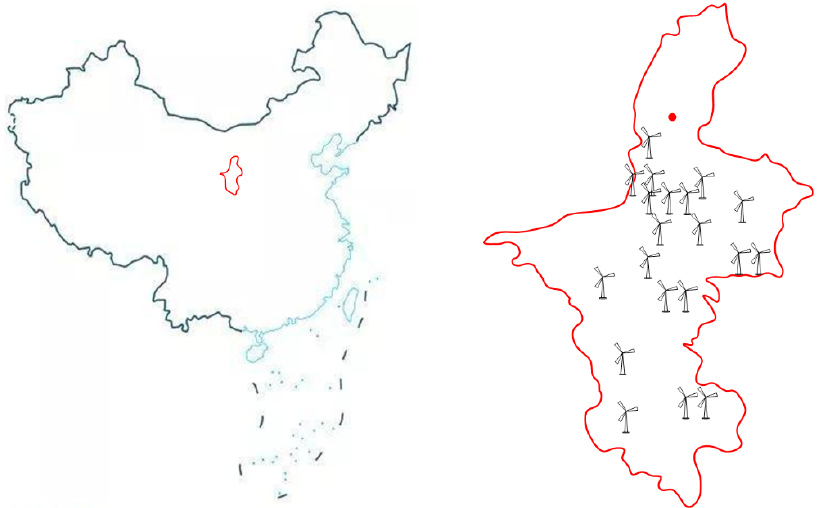
Figure 7. Geographical distribution of the 20 wind farms in the Ning Xia province of China.